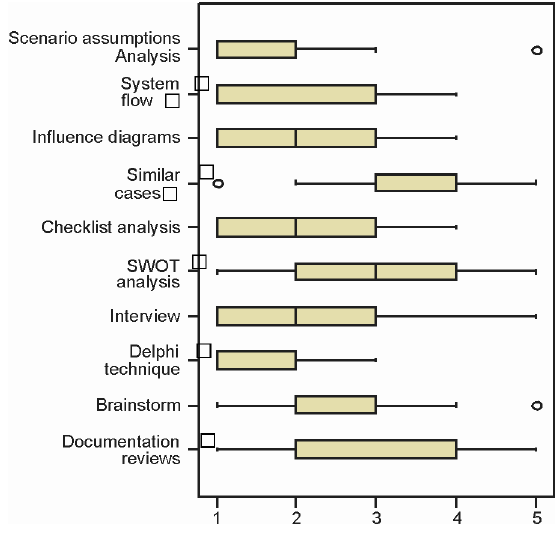
Fig. 7. Risk identification tool usage in PPP projects